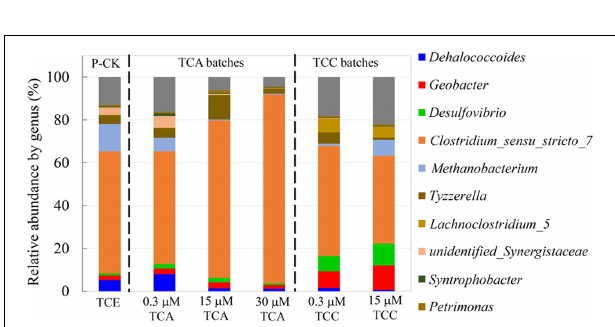
FIGURE 5 | The relative abundance of microbial structure composition at the genus level in different cultures. P-CK: positive